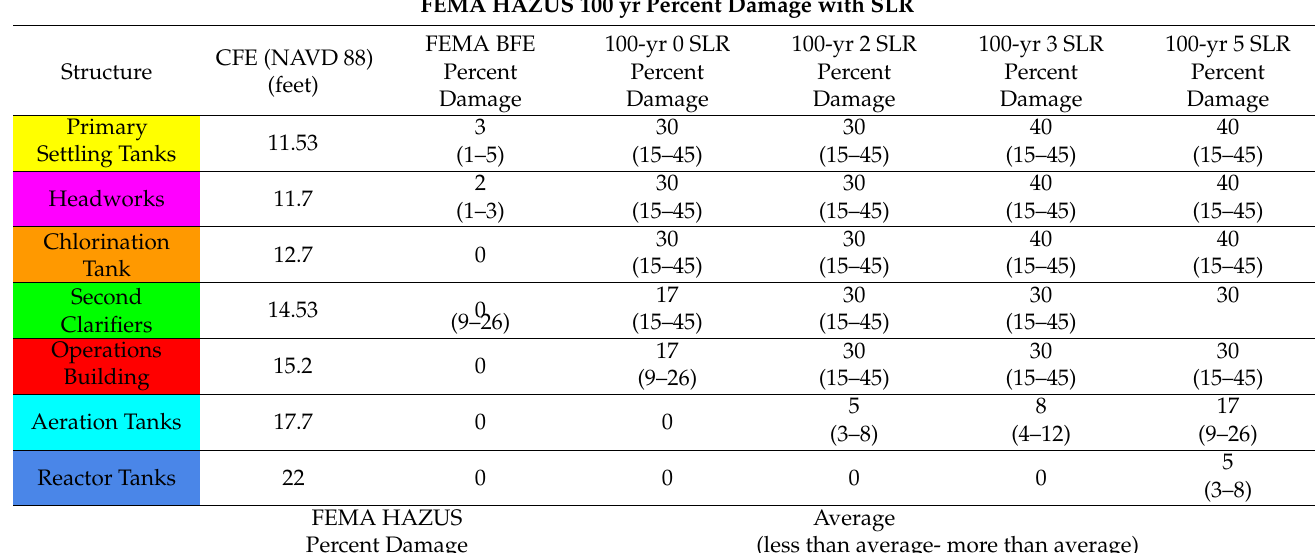
Table 2. Estimated damages (%) for individual components of the Warren, RI WWTF. Average damages are provided first, followed below by lower and upper bounds in parenthesis. Values are provided for FEMA BFE and SDE BFE with increasing SLR (0 to 5 ft).